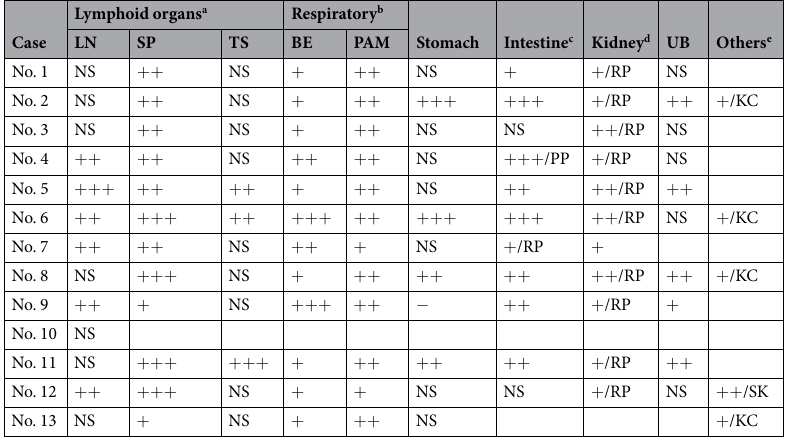
Table 2. Semi-quantitative distribution of CDV antigen in various non-central nervous system tissues by immunohistochemistry. Immunoreactivity grading: +++ marked positive, ++ moderate positive, + slight